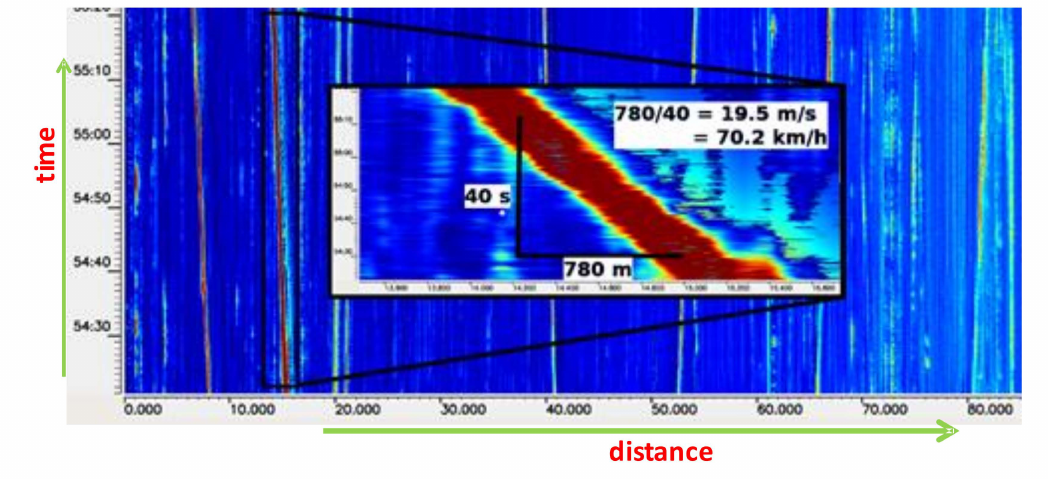
Figure 21. The waterfall with moving vibration sources (trains) and the source movement speed estimation.